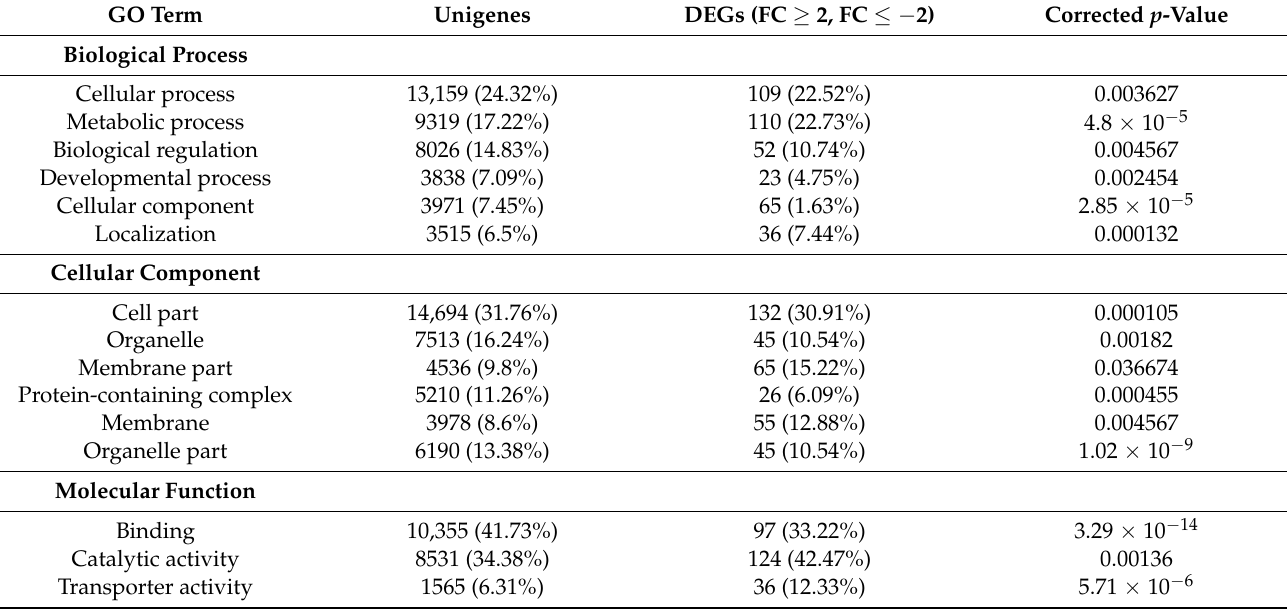
Table 3. Significantly enriched gene ontology (GO) terms in the differentially expressed genes (DEGs) coregulated by cold